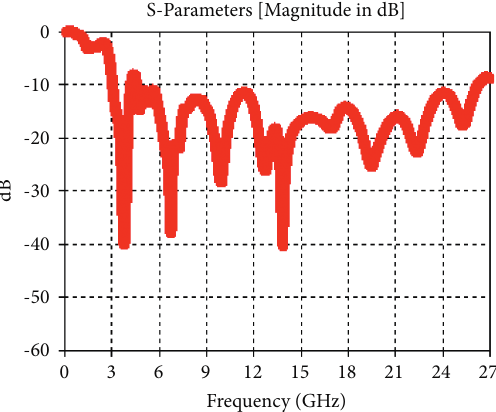
Figure 8: Return loss curve of Step 5 (proposed Vivaldi antenna). Table 2: Performance metrics of the proposed super wideband Vivaldi antenna.